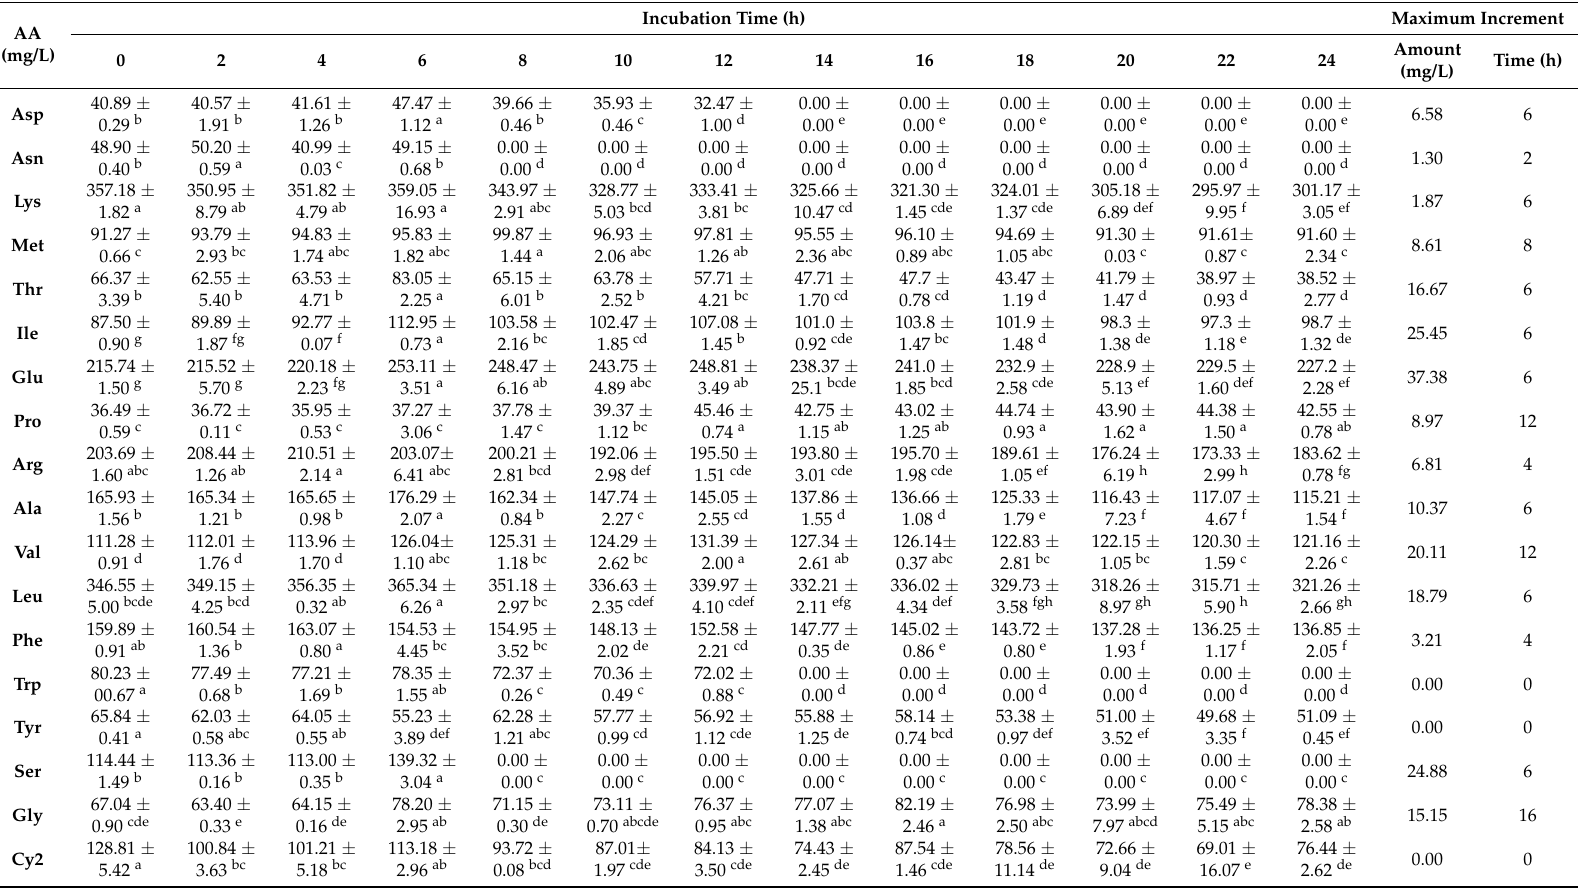
Table 7. The amino acid production profile of L. plantarum